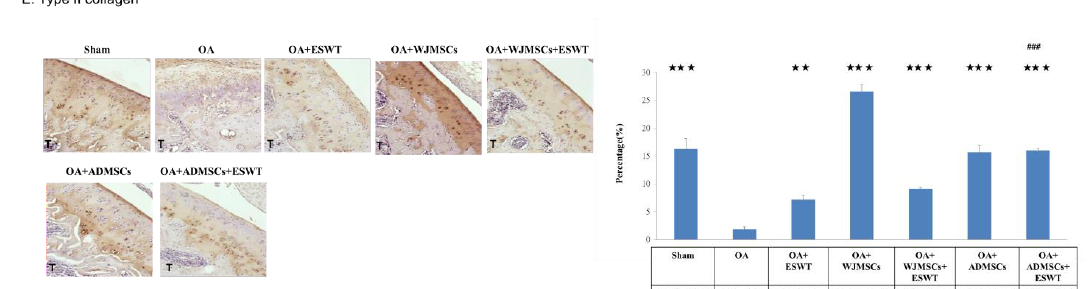
Figure 2. Treatments, histological analysis of synovium membrane, and Osteoarthritis Research Society International (OARSI) scores of the knee osteoarthritis (OA). ( A ) Sketch of the knee outlining the location of injection of WJMSCs or ADMSCs in the rats. In the left, ultrasound guidance (Toshiba